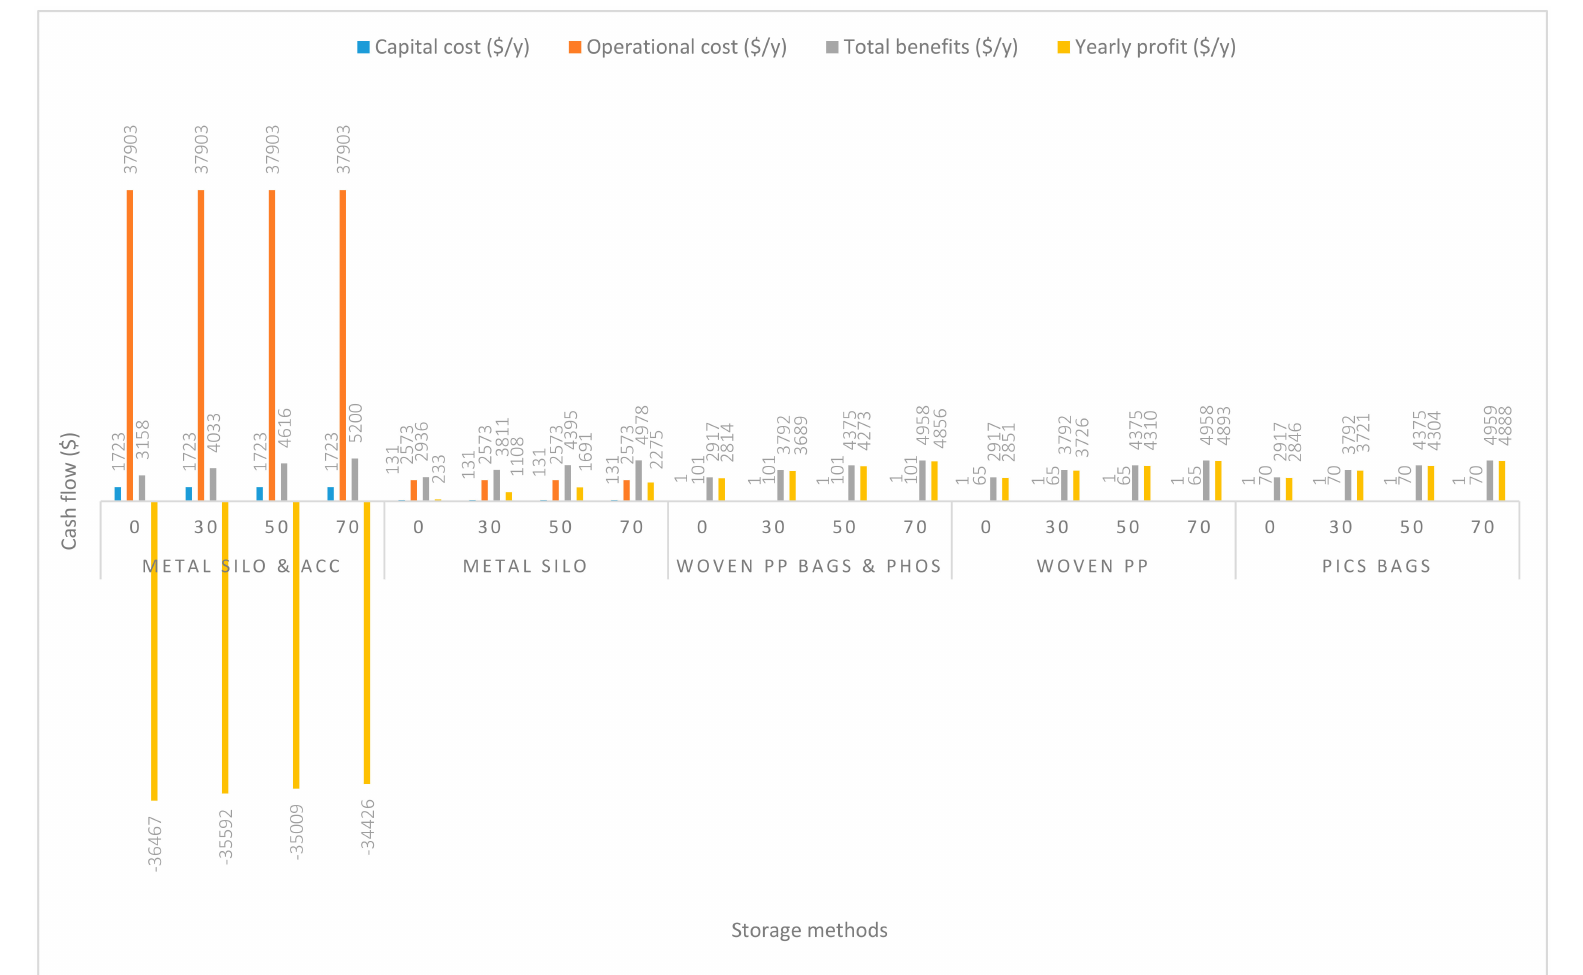
Figure 3. Annual capital and operational costs (US dollars), total annual benefits and profits (US dollars) for each handling / storage method at 14 Mg / y handling capacity for 0%, 30%, 50%, and 70% grain price